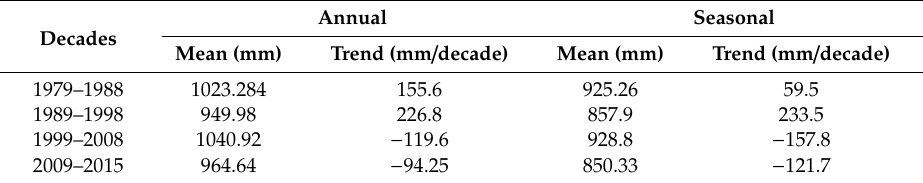
Figure 7. Time series of ( a ) annual and ( b ) seasonal rainfall over Malawi from 1979 to 2015. Table 2. Decadal mean annual and seasonal precipitation with trend of per decade.